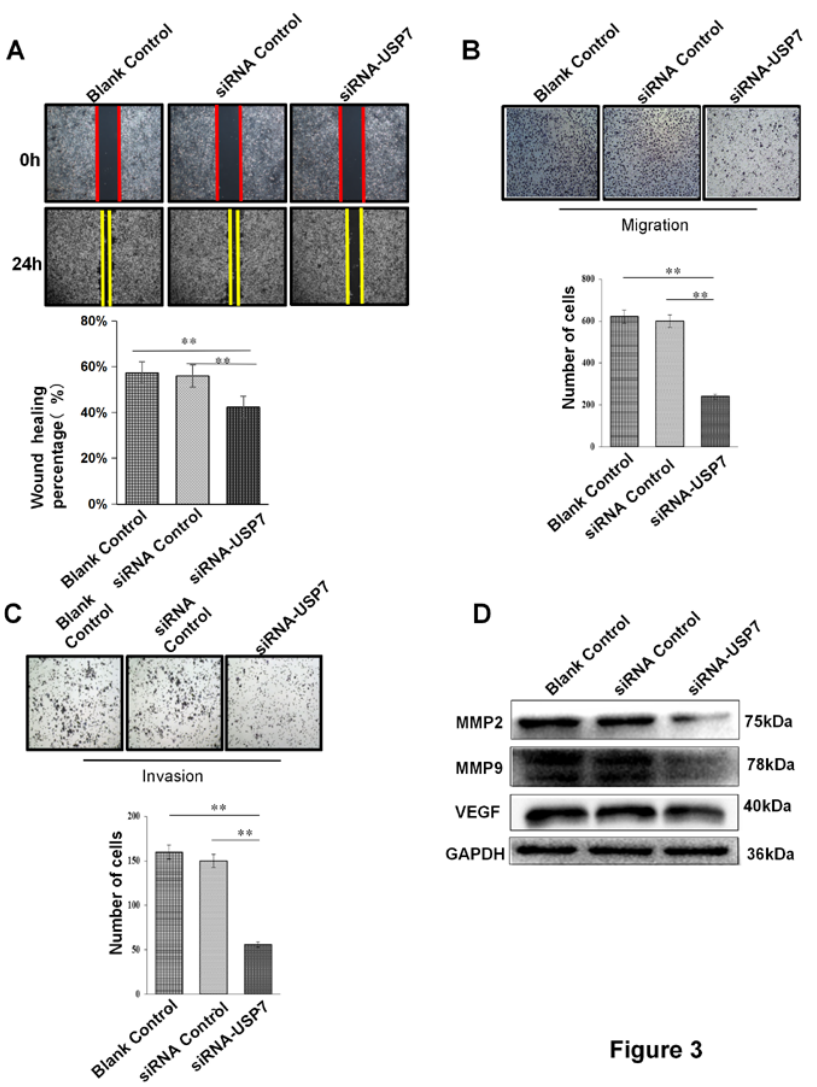
Figure 3 – USP7 knockdown suppresses migration and invasion of OSCC cells in vitro. A. Wound healing assay showed migrating ability was inhibited by USP7 knockdown in HSC3 cell line. B . Tranwell assay demonstrated that USP7 knockdown inhibited the migration ability of HSC3 cells. Statistics on the number of cell metastases after USP7 knockdown in HSC3 cells. C . Transwell test was performed to detect HSC3 cell invasive ability after USP7 knockdown. D . The relative gene expression of MMP2, MMP9, VEGF in HSC3 cells transfected with USP7 siRNA or siRNA negative control, blank control, were determined by WB analysis. GAPDH was used as a control. Data were presented as mean ± SEM,